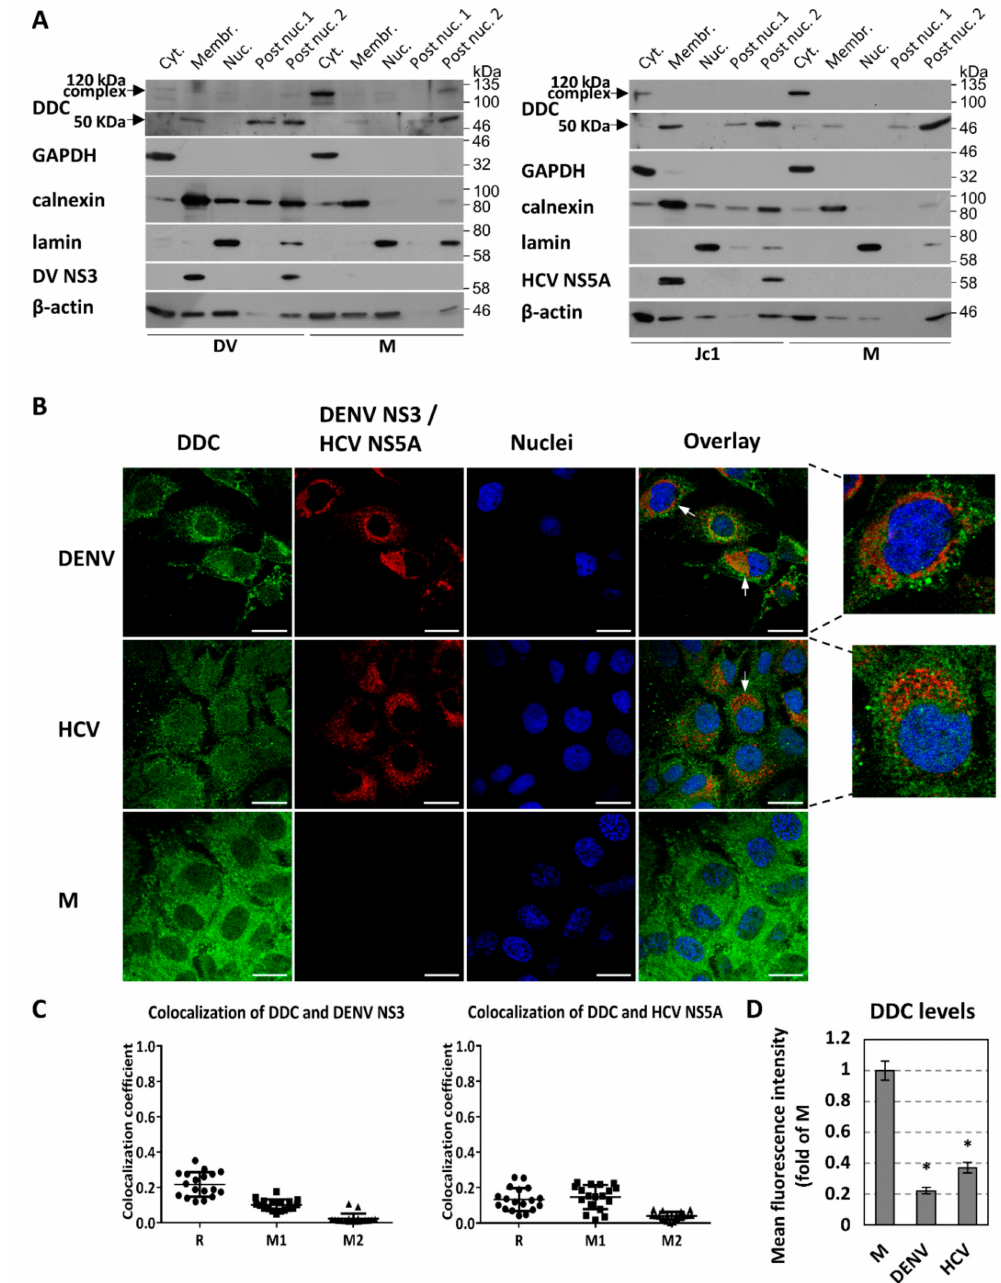
Figure 3. The influence of DENV and HCV infection on the subcellular fractionation and localization of DDC protein. ( A ) Subcellular distribution of DDC protein as detected by fractionation of Huh7 cells infected with DENV (DV-2 16681, MOI = 1) for 48 h (left), Huh7.5 cells infected with HCV (Jc1, MOI = 1) for 72 h (right) and mock-infected cells. Intracellular distribution of DDC protein in soluble cytosolic (Cyt), membrane-associated (Membr), nuclear (Nuc), and postnuclear insoluble (Post-Nuc) fractions was evaluated by Western blot analysis. GAPDH, calnexin, and lamin A served as specificity markers for the various fractions. The distribution of DENV NS3 and HCV NS5A were also analyzed. β -actin was used as loading control of infected and mock-infected cells. A representative experiment of three independent repetitions is shown for each virus. ( B – D ) The subcellular localization of DDC, as detected by immunofluorescence, in relation to viral proteins in Huh7.5 cells infected with DENV (MOI = 1)